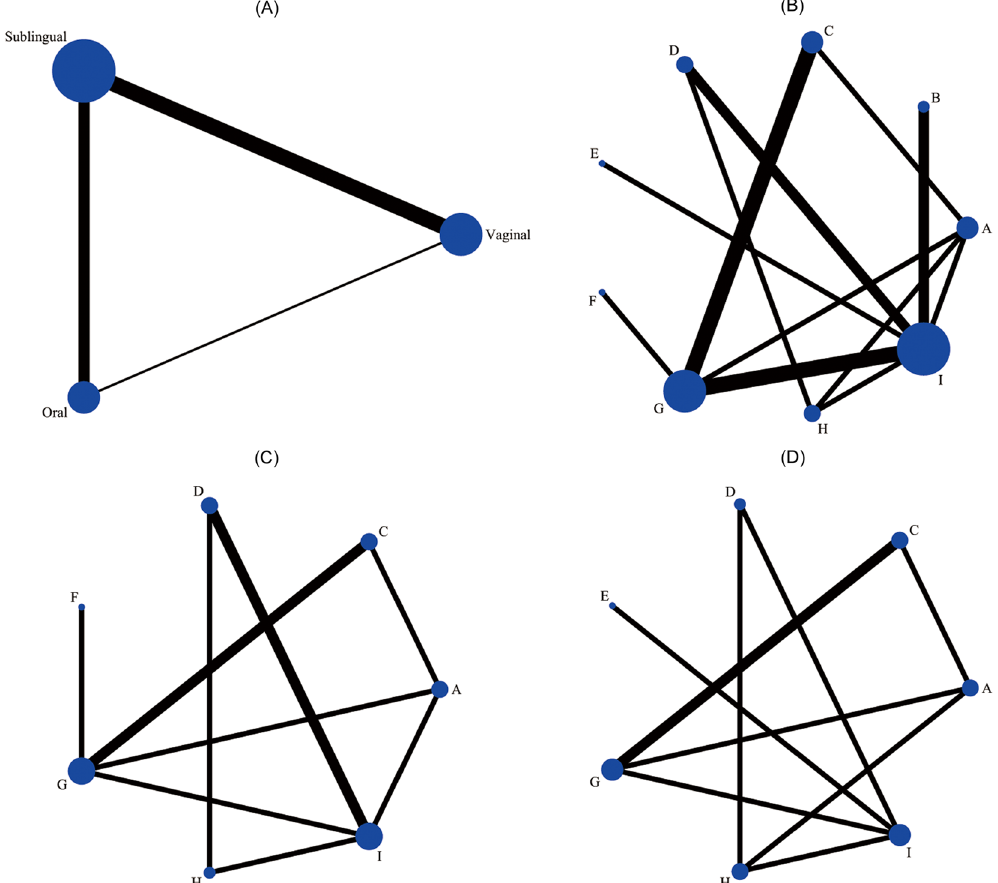
Figure 2. Network diagram of all studies and studies included in analyses of complete abortion rate within about 24 hours and main side effects. ( A ) Studies comparing different routes of misoprostol. ( B ) Studies comparing different routes or doses of misoprostol. ( C ) Complete abortion rate within about 24 hours. ( D ) Main side effects totally. Studies are classified according to the first dose of misoprostol in both groups; The width of the lines is proportional to the number of trials directly comparing each pair of interventions; The size of each node is proportional to the number of trails comparing a single intervention totally. Interventions are sequenced as follows: A. Oral 400 ug; B. Oral 800 ug; C. Sublingual 400 ug; D. Sublingual 600 ug; E. Sublingual 800 ug; F. Vaginal 200 ug; G. Vaginal 400 ug; H. Vaginal 600 ug; I. Vaginal 800